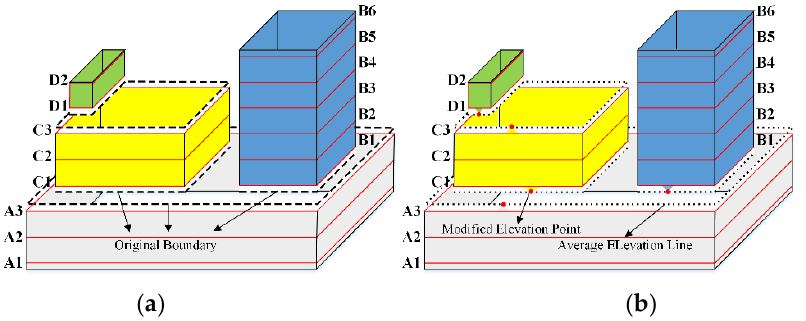
Figure 3. Illustration of decomposition of the photogrammetric mesh model: ( a ) decomposed photogrammetric mesh model components; ( b ) photogrammetric mesh model components after modi- fication.